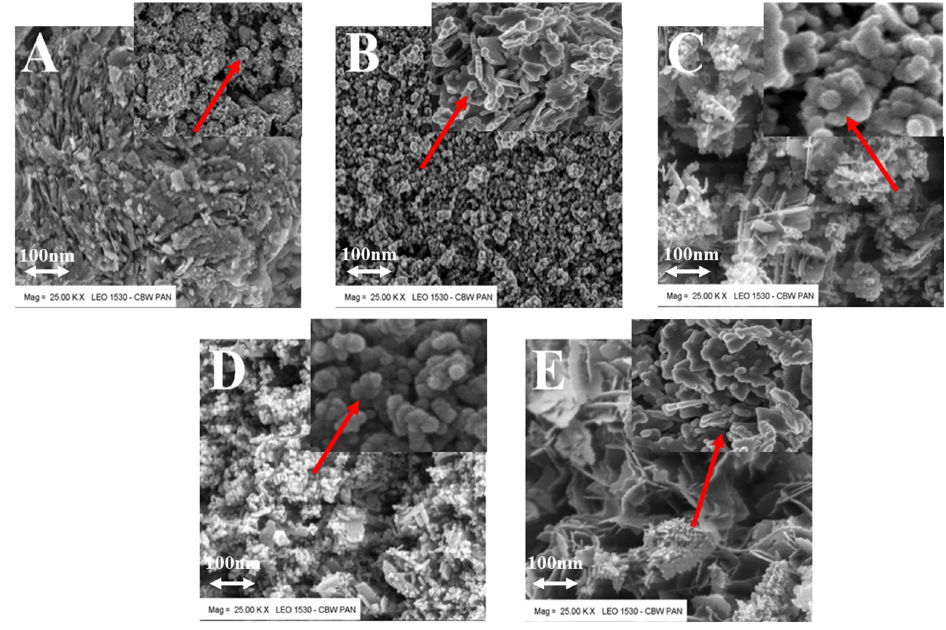
Figure 6. SEM pictures: ( A ) microwave reactor; ( B ) autoclave; ( C ) meander-type heater; ( D ) Joule type heater; ( E ) impulse reactor.